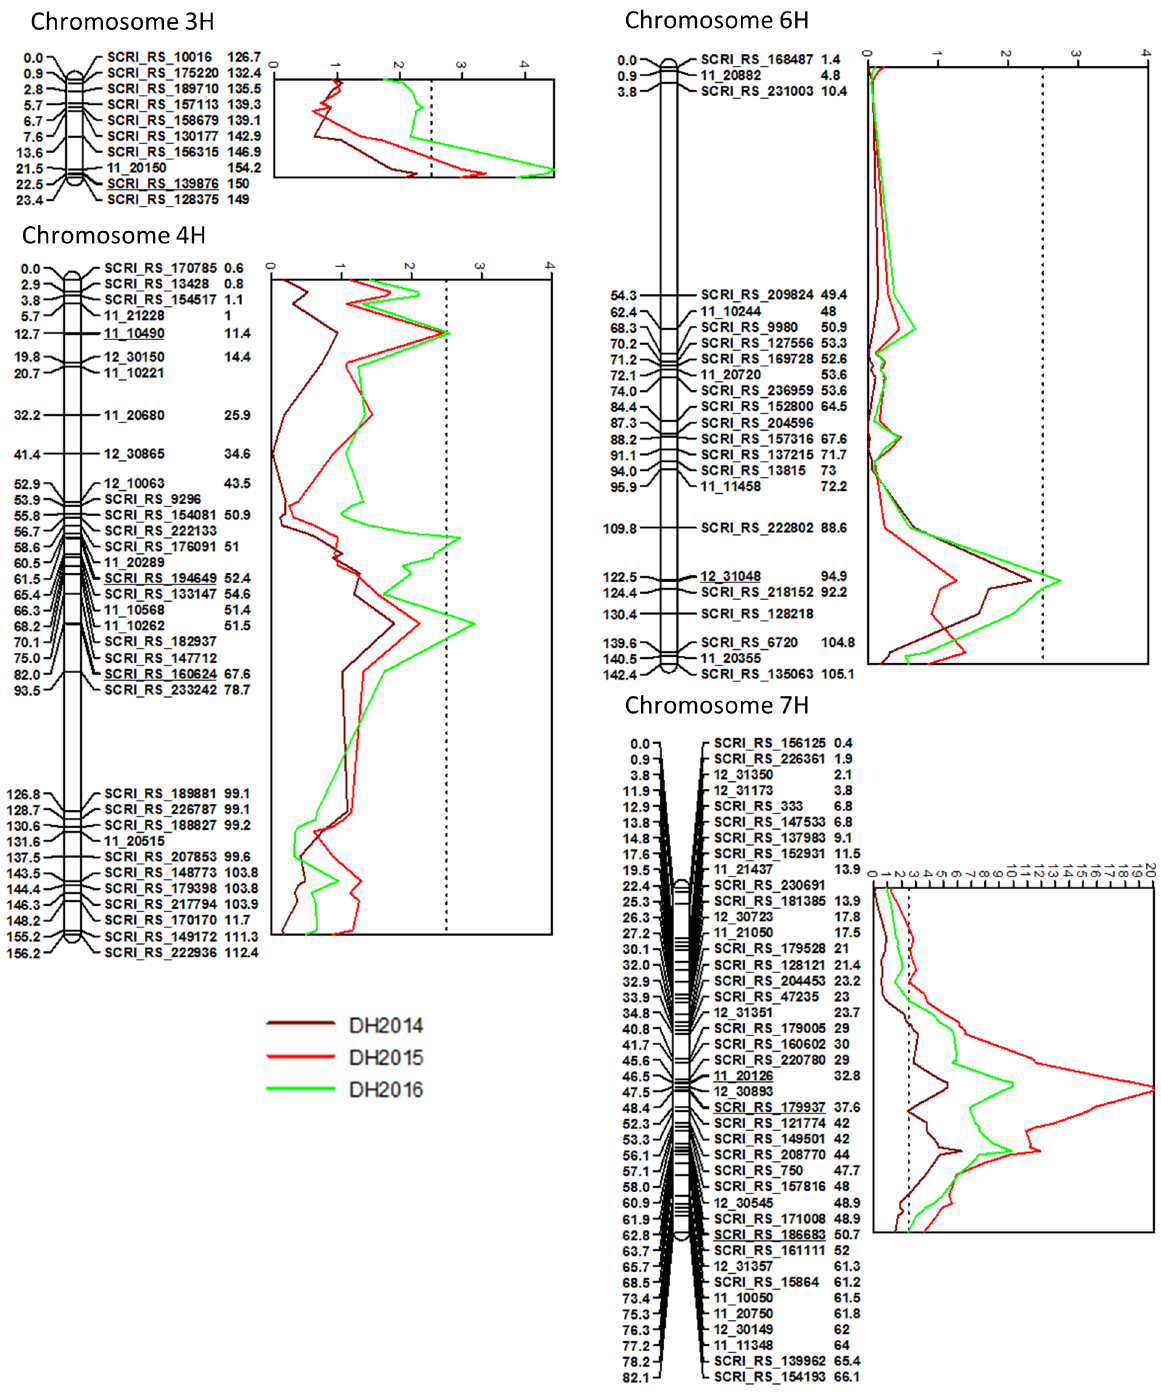
Fig 3. Chromosomes with significant QTL for DH in the Arve x Lavrans population with LOD curves obtained with interval mapping. Genetic distances on the AxL map are given in cM on the left side of the linkagemap bars. The numberson the right side of the marker names refer to the POPseq position of the marker [25]. Only one marker per positionwas kept. The dashed lines indicate the LOD thresholdof 2.5 determined by permutation test.